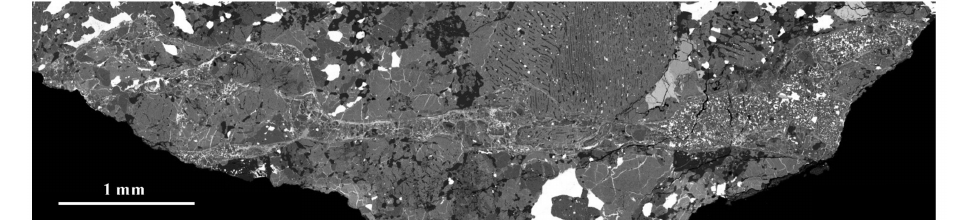
Figure 2. Backscattered electron (BSE) image of the shock vein in the GRV053584. The shock vein is located along the sample